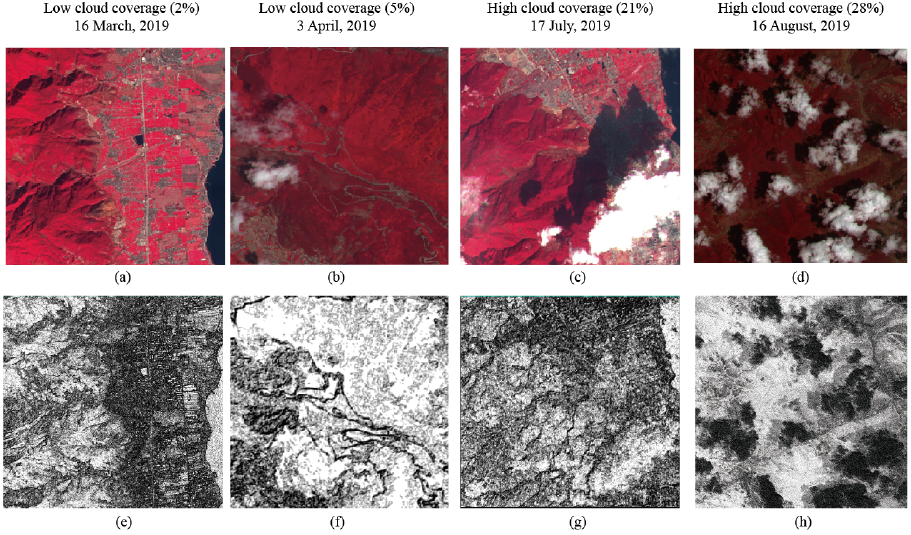
Figure 6. Examples of low and high cloud coverage areas; ( a – d ) represent images of Sentinel-2 (band composition: 8, 4, 3); ( e – h ) are corresponding IDM features of NDVI.